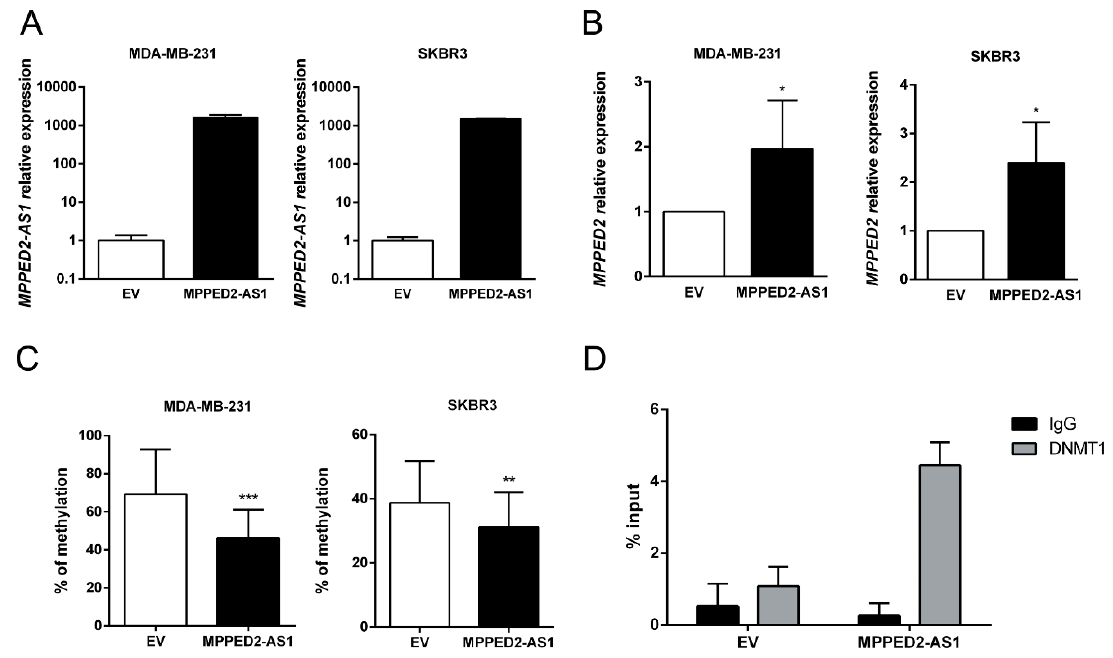
Figure 4. MPPED2-AS1 interacts with DNMT1 decreasing MPPED2 promoter methylation. ( A ) qRT-PCR analysis of MPPED2-AS1 expression levels in MDA-MB-231 and SKBR3 cells transfected with MPPED2-AS1 overexpressing vector or the empty vector (EV). Data are reported as 2 − ∆∆ Ct values ± SD, compared to the EV, set equal to 1. ( B ) qRT-PCR analysis of MPPED2 mRNA levels in MDA-MB-231 and SKBR3 cells transfected with MPPED2-AS1 overexpressing vector or the empty vector (EV). Data are reported as 2 − ∆∆ Ct value ± SD, compared to EV, set equal to 1. t -test: *, p < 0.05 (MDA-MB-231 and SKBR3). ( C ) MPPED2 promoter methylation levels were evaluated in MDA-MB-231 and SKBR3 cells transfected with MPPED2-AS1 overexpressing vector or the empty vector (EV). t -test: ***, p < 0.001 (MDA-MB-231); **, p < 0.01 (SKBR3). ( D ) RNA immunoprecipitation was performed on extracts obtained from SKBR3 cells transfected with MPPED2-AS1 overexpressing vector or the empty vector (EV), using an anti-DNMT1 antibody or a pre-immune (IgG) serum, as control. Immunoprecipitated MPPED2-AS1 RNA was quantified by qRT-PCR. RNA levels were reported as percentage of input and were calculated with the 2 − ∆ Ct formula.